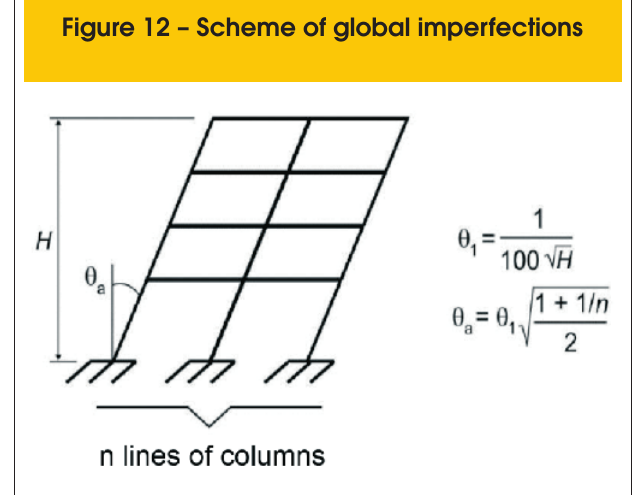
Figure 12 – Scheme of global